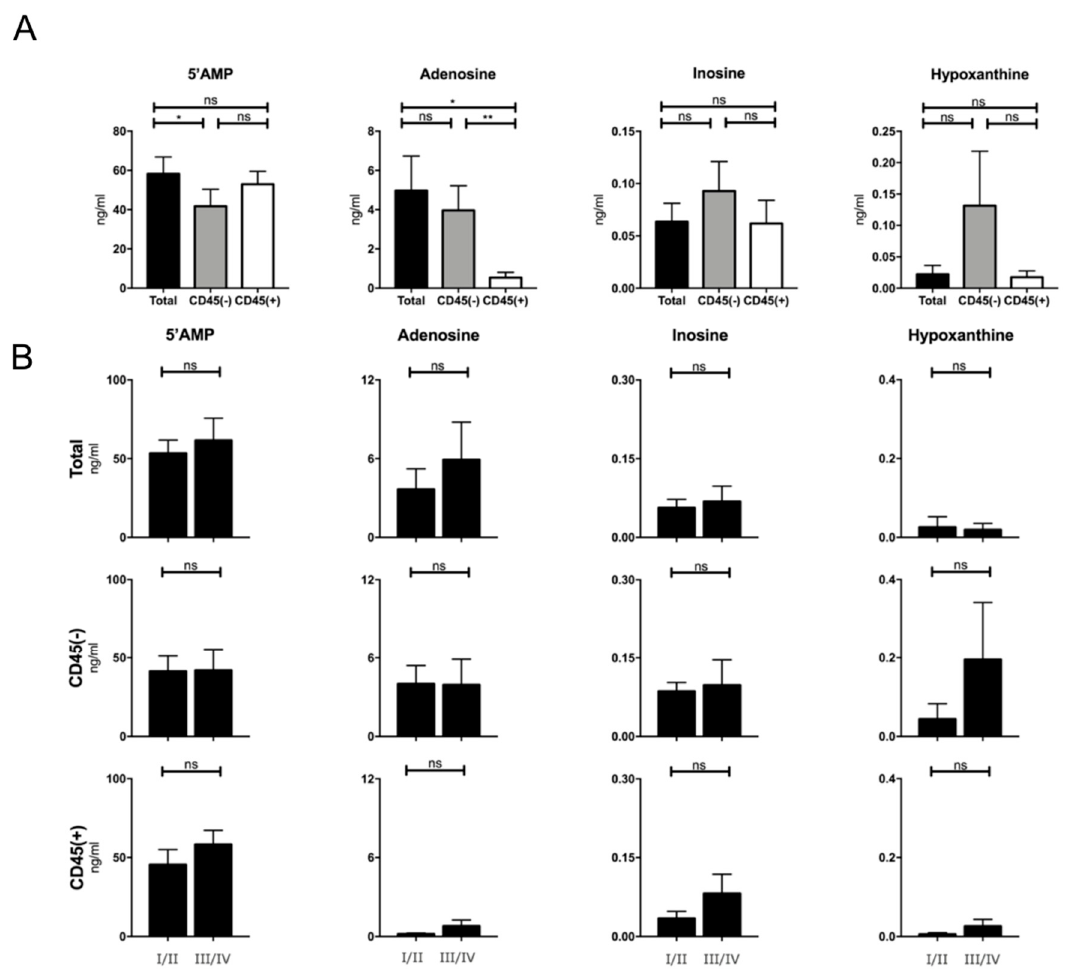
Figure 6. Production of nucleosides by exosomes of all stages. ( A ) Respectively, 5 ′ adenosine monophosphate (5 ′ AMP), Adenosine, Inosine, and Hypoxanthine production by total, CD45(+) and ( − ) exosome fractions. The different exosome fractions showed significant differences between 5 ′ AMP and adenosine production; n = 18; ( B ) Production of nucleosides in ng/mL by total exosomes comparing UICC low and high stage patients; n = 19. Mann-Whitney with * p < 0.05, *** p < 0.005, bars represent standard error of mean (SEM).